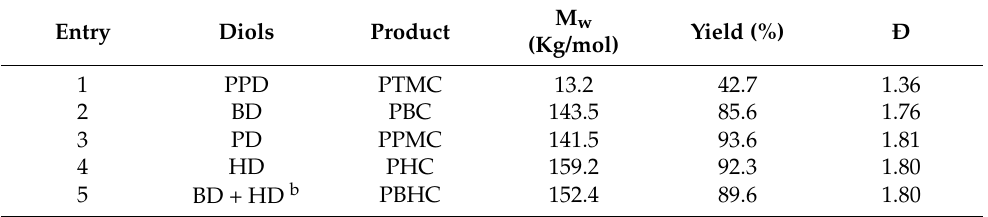
Table 2. Melt transesterification of DPC with a verity of diols in the presence of the Zn(Acac) 2 catalyst a